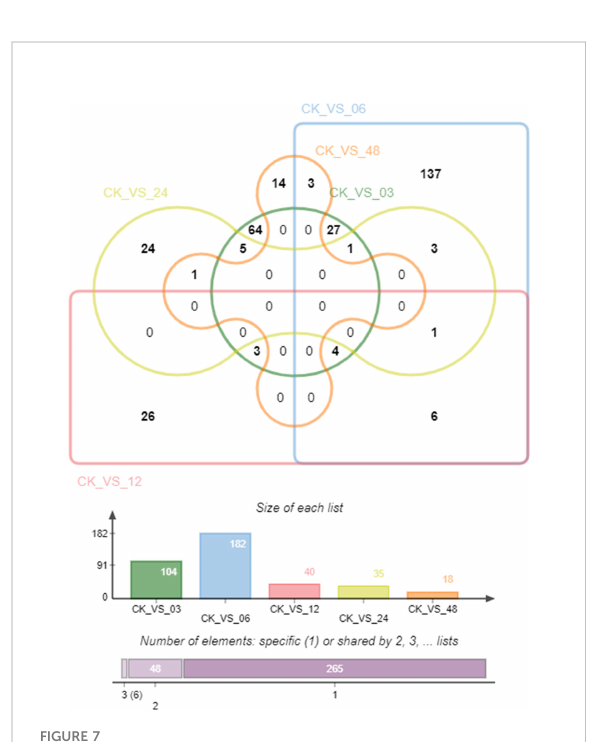
FIGURE 7 Distribution of differentially expressed genes (DEGs) at different time